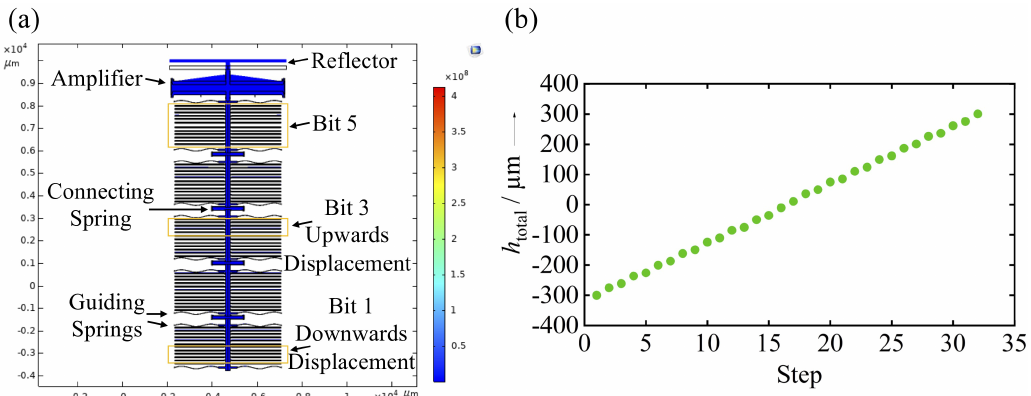
Figure 4. ( a ) Simulated 5-bit system, ( b ) Simulation result: total bi-directional throw of 300 µ m performing 32